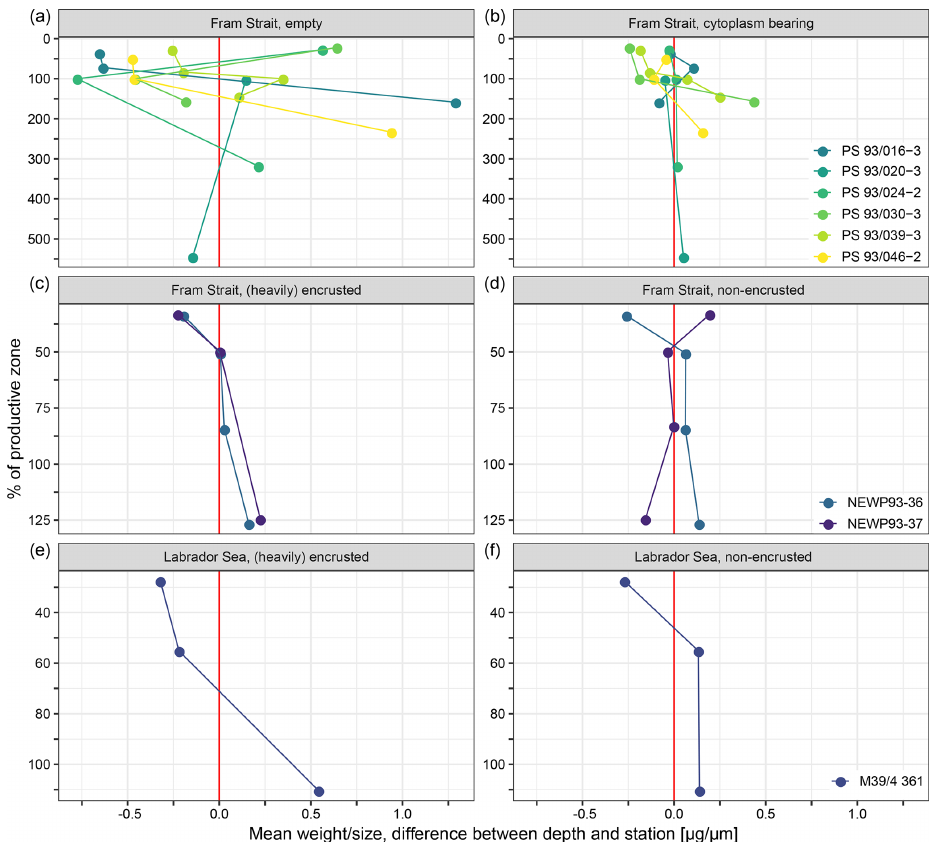
Figure 7. Mean of the difference in average calcification intensity (weight / size) at individual stations and depths and the overall weighted mean of each station within the productive zone, plotted against the percentage of the depth interval on the overall depth of the productive zone. 100% equals the total depth of the productive zone and 50% half of the depth of the productive zone. More than 100% is reached where the sampling interval ends below the BPZ. Differentiation of shell types is done between cytoplasm-bearing and empty shells from Fram Strait samples of this study (a, b) , while Kohfeld et al. (1998) (c, d) and Stangeew (2001) (e, f) distinguished between (heavily) encrusted and non-encrusted shells in samples from the Fram Strait and the Labrador Sea. The red line indicates the position at which no difference between the mean of the depth and the overall station exists, and different colours are used to make the shape of change in individual profiles